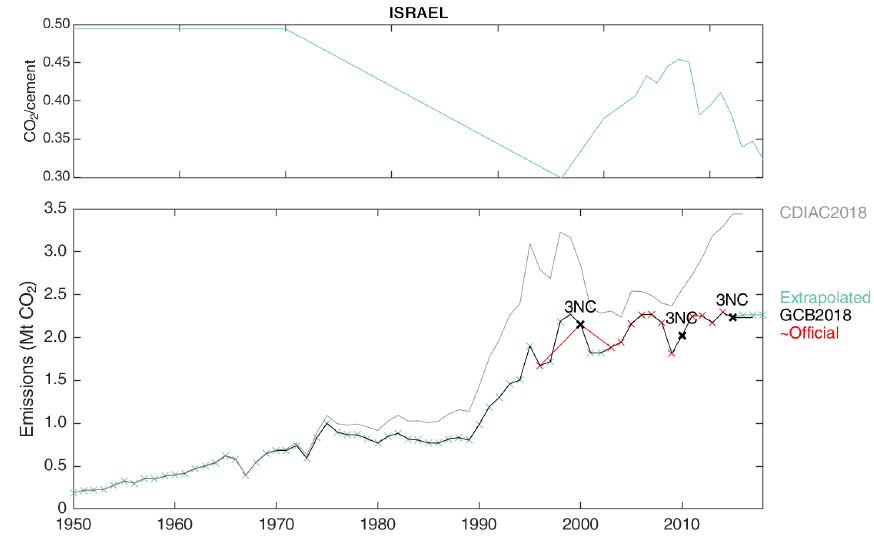
Figure C23. Revised cement emissions in Israel.